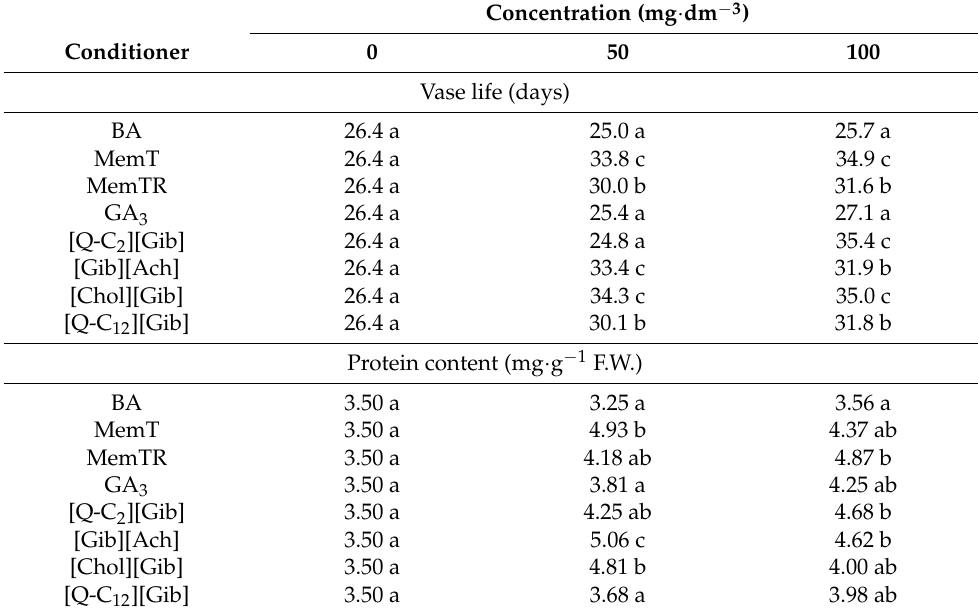
Table 2. Vase life (days) of leaves, protein, and chlorophyll a + b content (mg · g − 1 F.W.) in leaves of Hemerocallis × hybrida ‘Agata’ depending on conditioner type and concentration. Means followed by the same letter column-wise and row-wise do not differ significantly at α =